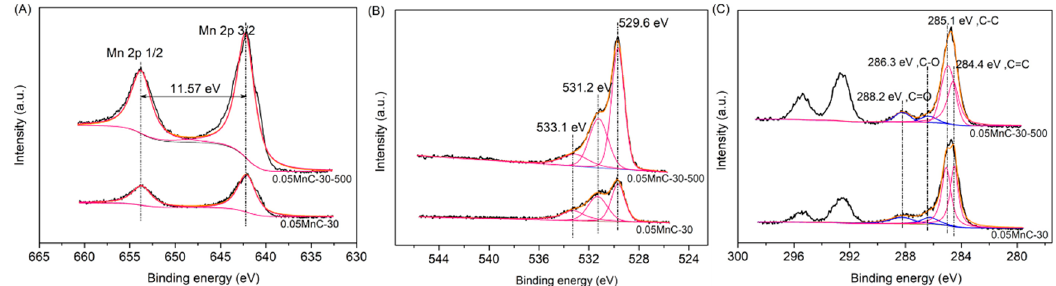
Figure 8. XPS spectrum of 0.05Mn − C − 30 − 500 and 0.05MnC − 30: ( A ) Mn2p; ( B ) O1s: ( C )